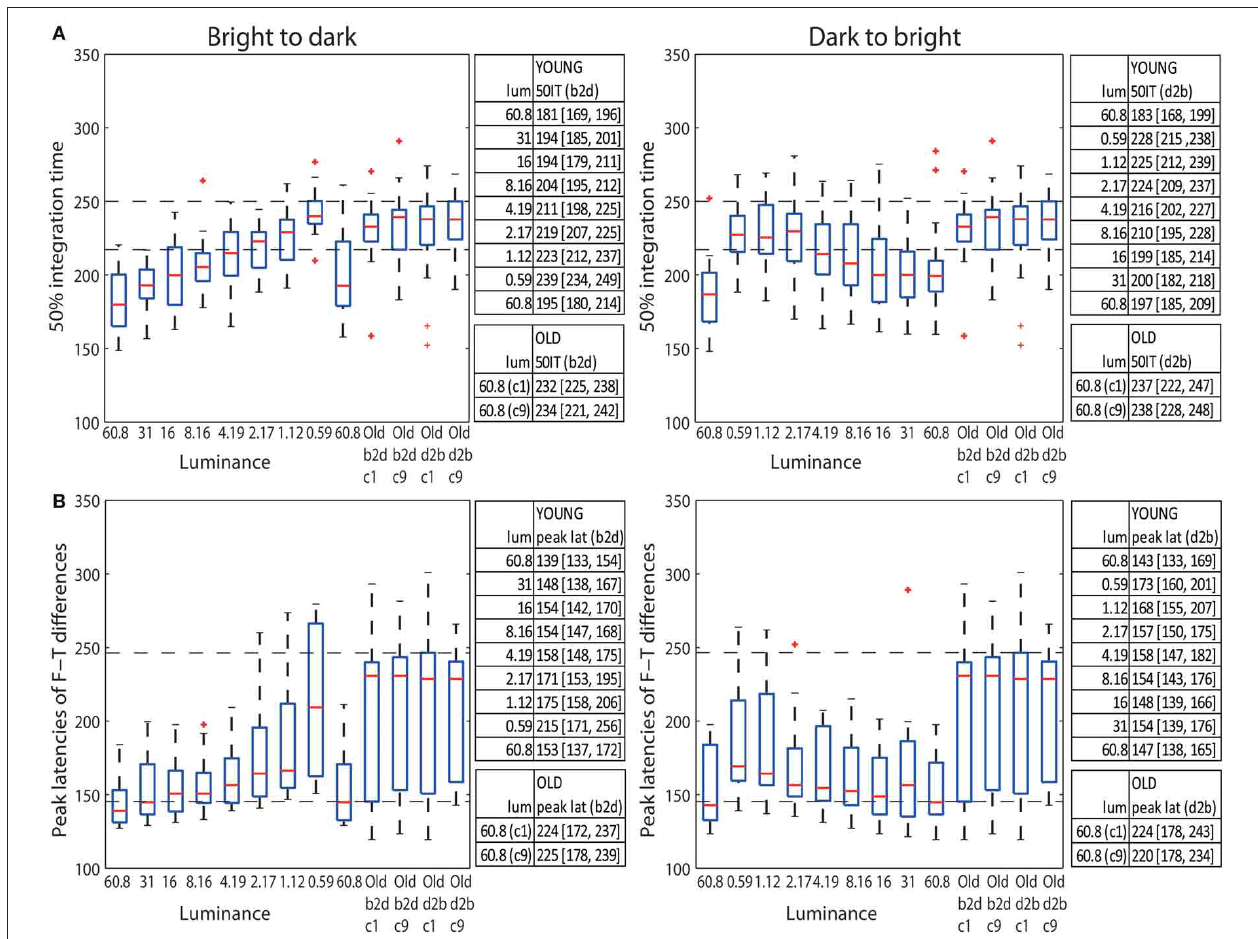
in the tables to the right of the subplots. For young subjects median 50IT and peak latencies for all conditions are given; for old subject, they are given for the two brightest conditions [condition 1 (c1) and 9